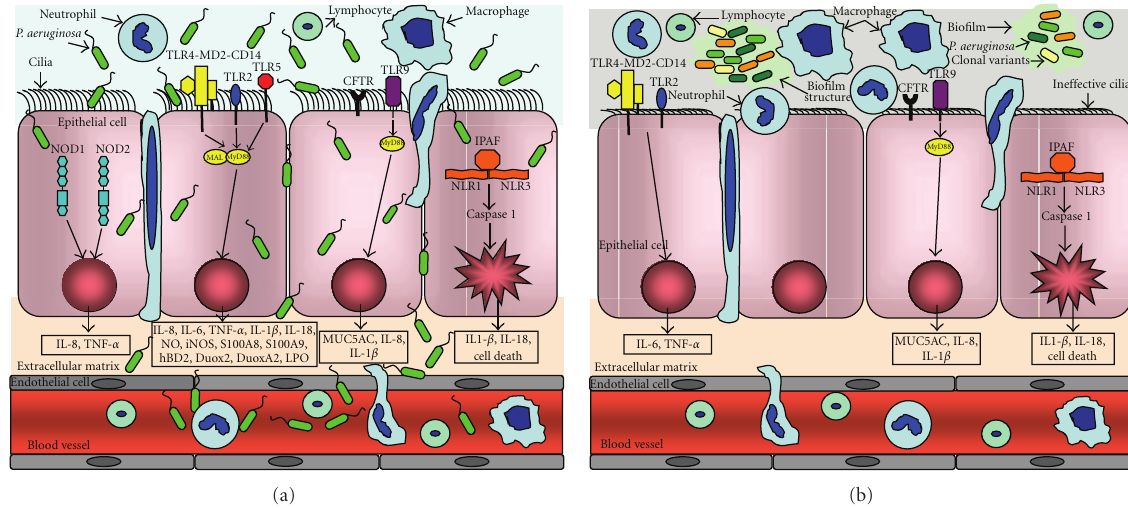
Figure 1: Pseudomonas aeruginosa recognition by PRRs during acute and chronic lung infection. (a) During acute lung infection, P. aeruginosa can invade, disseminate and lead to extensive tissue damage by means of potent array of extracellular and cell bound virulence factors. However the immunocompetent host mounts an e ff ective immune response characterized of bacterial recognition by cell surface receptors, which are located on immune cells as well as epithelial cells. Plasma membrane-bound TLRs (TLR2, TLR4-MD2-CD14, TLR5, and TLR9) and cytosolic NLRs (NOD1, NOD2, and IPAF) recognise P. aeruginosa PAMPs and recruit adaptors to induce downstream signalling cascades, which result in transcription of pro-inflammatory mediators and mucins. These pro-inflammatory mediators, including chemokines, recruit immune cells to the lung in order to clear P. aeruginosa and resolve the infection. (b) During chronic lung infection, P. aeruginosa, enmeshed in biofilm structures, does not have direct contact to the airways epithelium and probably only immunogenic bacterial components can access to airway epithelium and immune cells in the lung. In addition, during long-term colonization, bacteria undergo a number of genetic changes and gain the ability to evade detection and clearance by the immune system, thus surviving in the host. The loss or modification of several PAMPs (flagellin, LPS, and PGN) lead to reduced recognition by TLRs and NLRs although components of the alginate capsule can still be recognized both by TLR2 and TLR4. The inadequate immune response may explain the chronic colonization of P. aeruginosa strains. NOD, Nucleotide-binding oligomerization domain; TLR, Toll-like receptor; NLR, Nod-like receptor; IPAF, ICE-protease activating factor; MyD88, myeloid di ff erentiation primary response protein; CFTR, cystic fibrosis transmembrane conductance